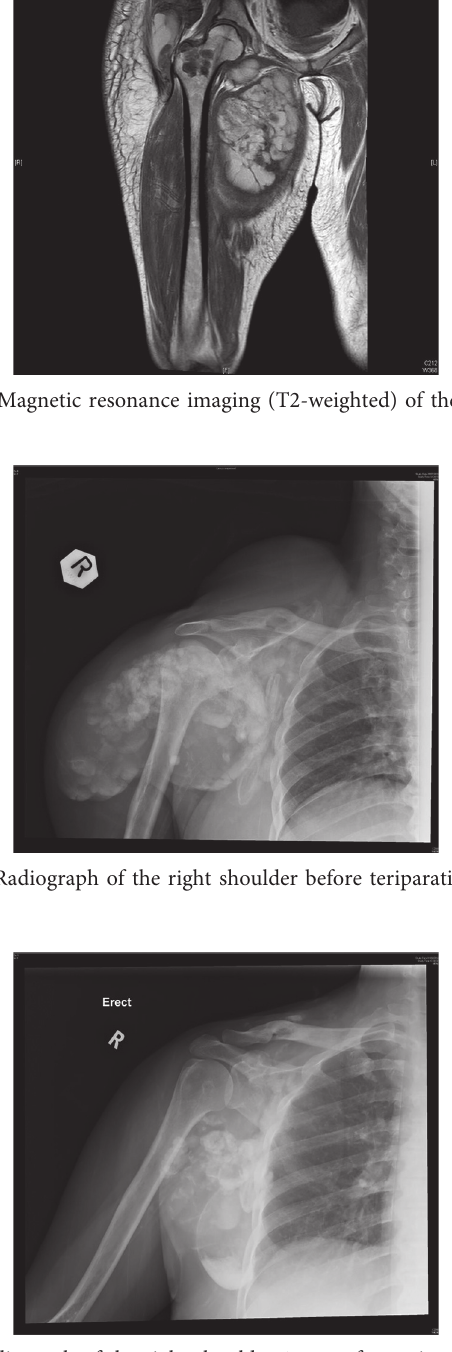
Figure 5: Radiograph of the right shoulder 1 year after teriparatide